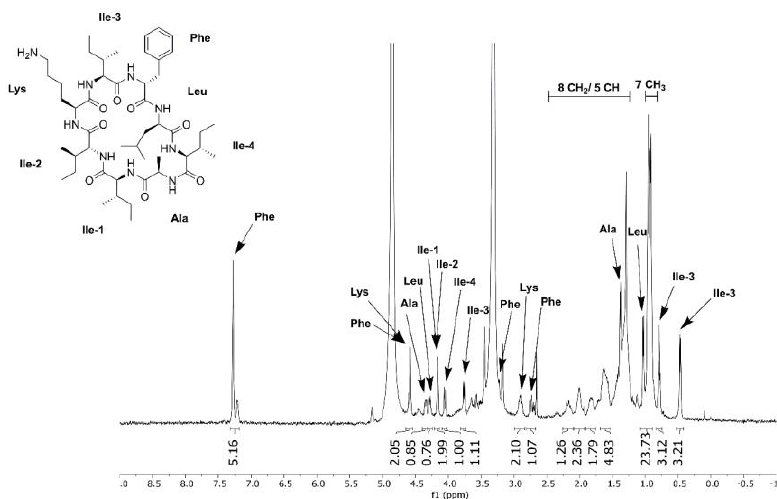
Figure 7. Structure of surugamide A isolated from SM17 grown in TSB, SYP-NaCl, and YD medium with annotated 1 H NMR spectrum obtained in CD 3 OD at 500 MHz.